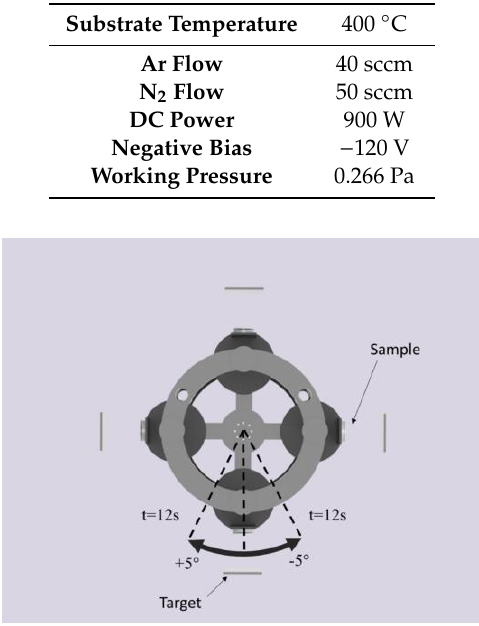
Table 1. Constant deposition parameters used to manufacture the CrN and Cr 1 − x Al x N ceramic coatings. Substrate Temperature